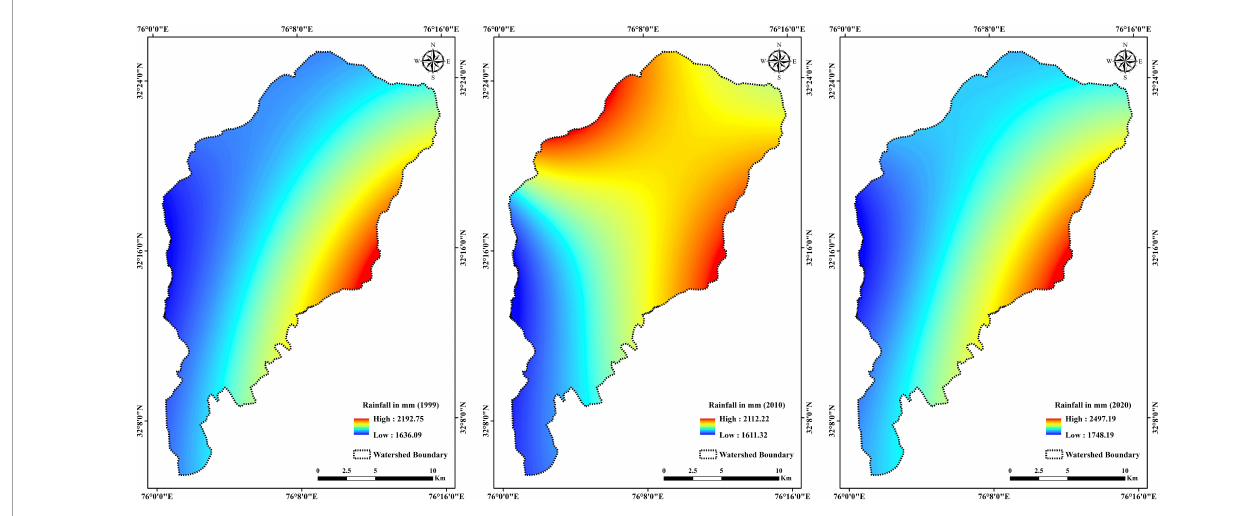
FIGURE3 Maps of the Dehar watershed showing the average annual rainfall for the years 1999, 2010, and 2020.